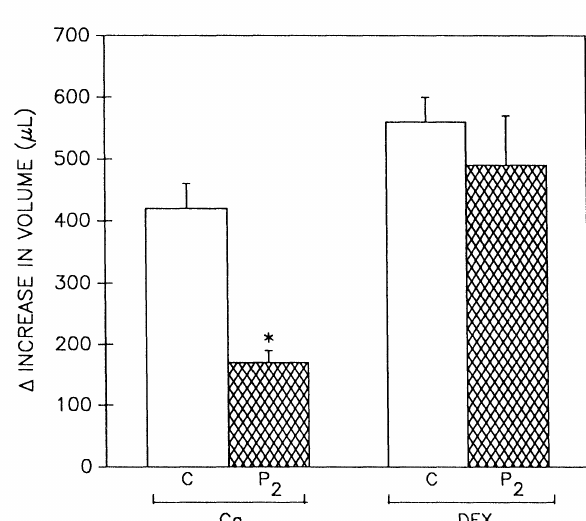
FIG. 4. Inhibitory effect of P2 fraction on carrageenin-induced oedema. The bars show the increase in volume induced by 100 #g i.pl. injection of either carrageenin (Cg) or dextran (DEX) in animals pretreated 15 min before with i.v. injection of either PBS" (C, control) or P2 fraction (P2). Oedema was measured 4 h after challenge. The .results are reported as the means +__ SEM of five animals per experimental group. *p < 0.01 as compared to controls. Student’s t-test.